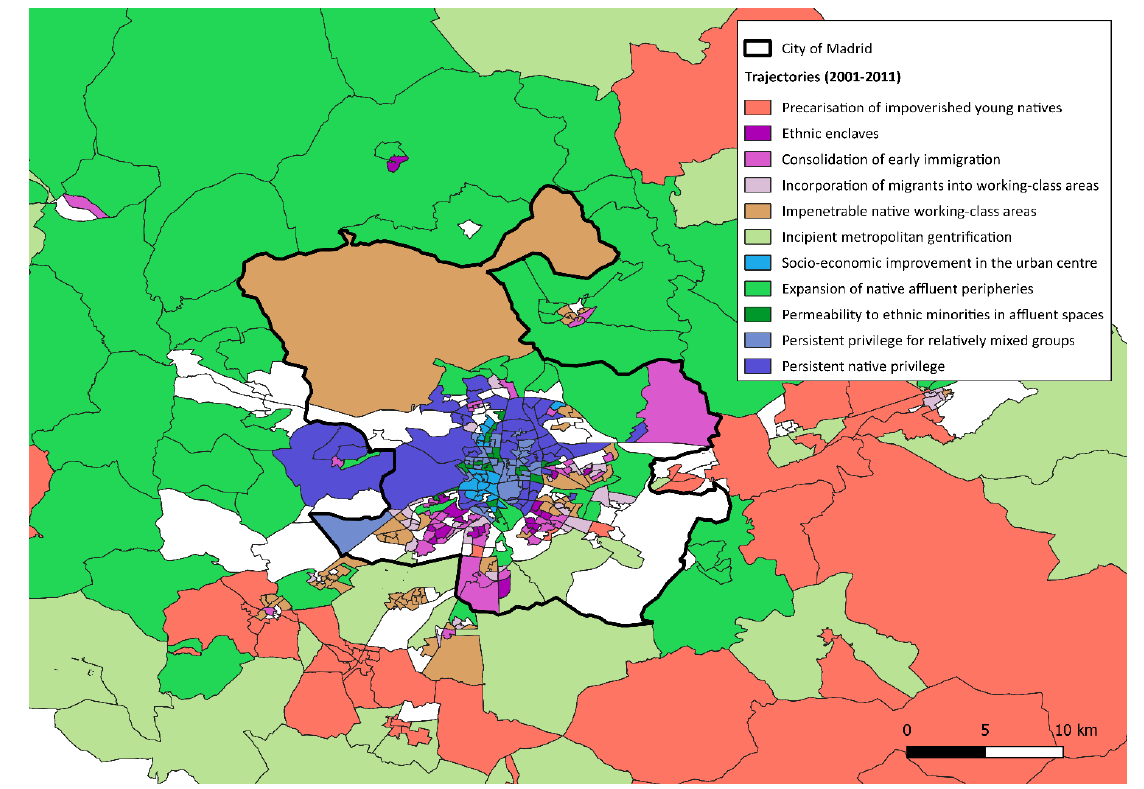
Figure 1. Main trajectories of social residential change (2001–2011) in the Region of Madrid. Source: Drawn up by the authors based on the 2001 and 2011 Population and Housing censuses (INE, 2004, 2013).